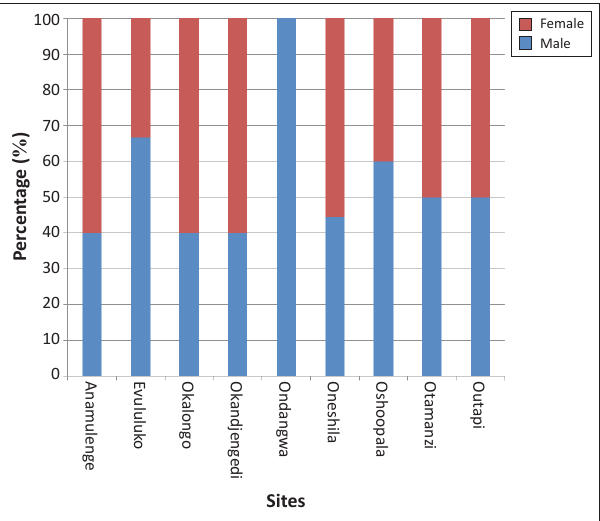
FIGURE 3: Gender by sites visited. FIGURE 5: Informant groups as per sites visited.